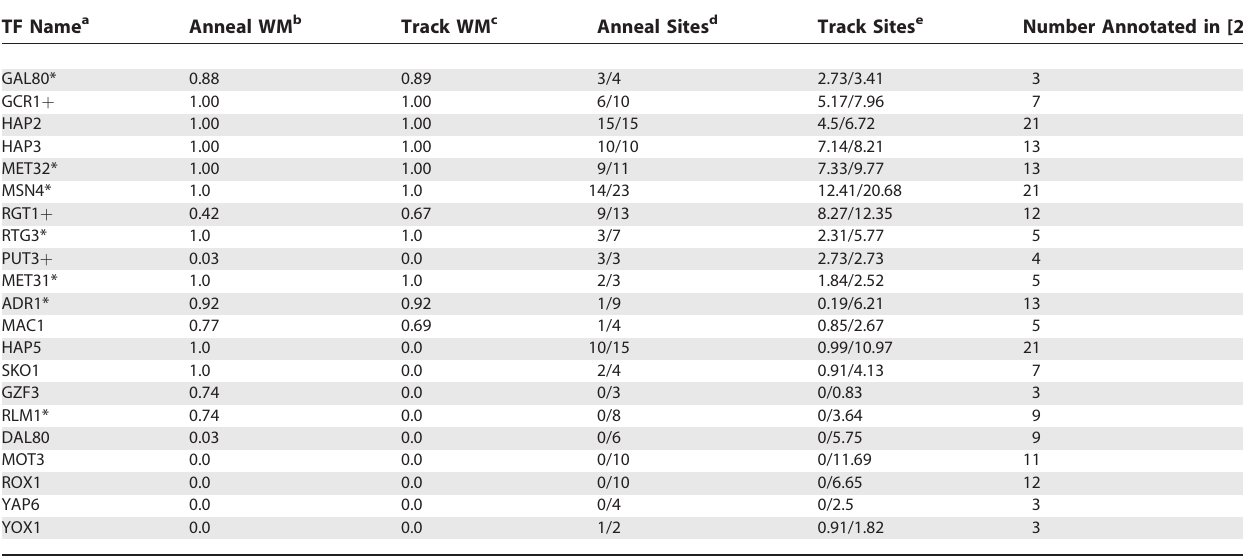
Table 1. Results of PhyloGibbs on Collections of Intergenic Regions for 21 TFs for Which the Motif-Finding Algorithms in [27] Failed to Recover a Significant Motif but for Which a Literature Consensus Motif Is